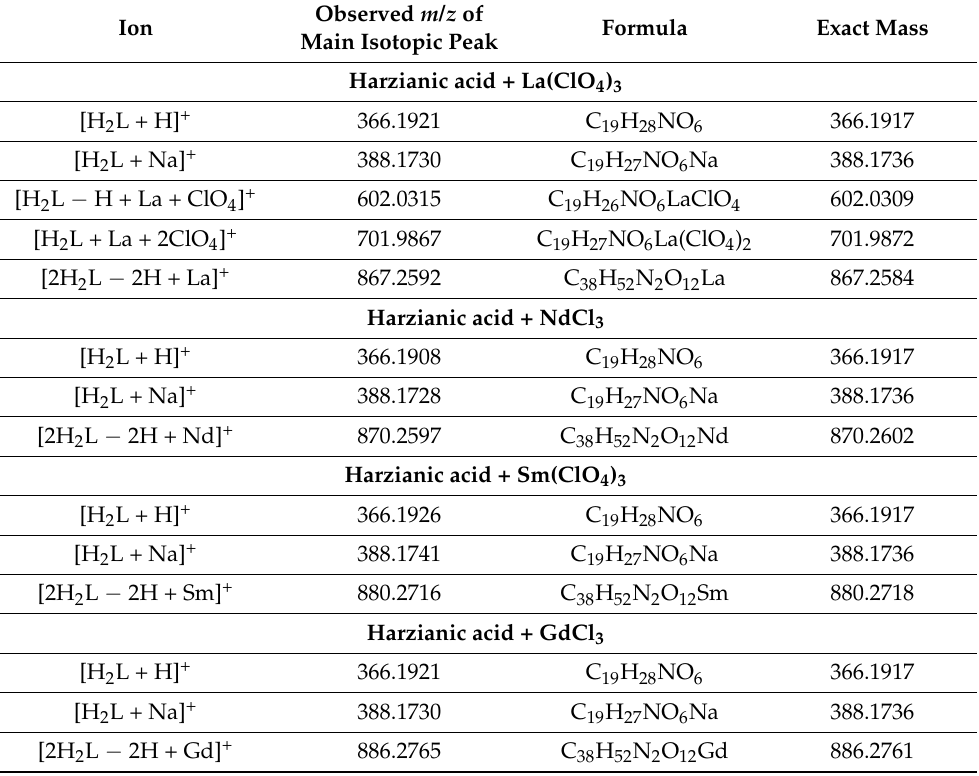
Table 1. Characterization of Ln 3+ /harzianic acid complex by HPLC–ESI–HRMS. Observed m / z of Formula Exact Ion Main Isotopic Peak